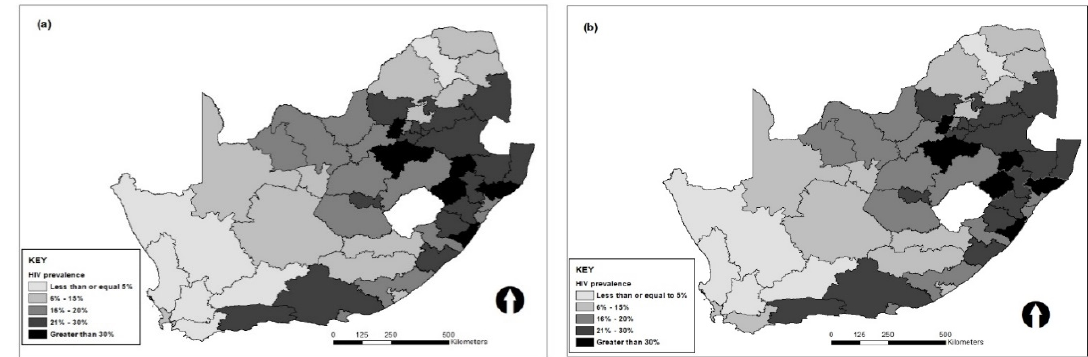
Figure 1. Map of HIV prevalence by district in South Africa before ( a ) and after ( b ) adjusting the data for zero positive tests in some districts.